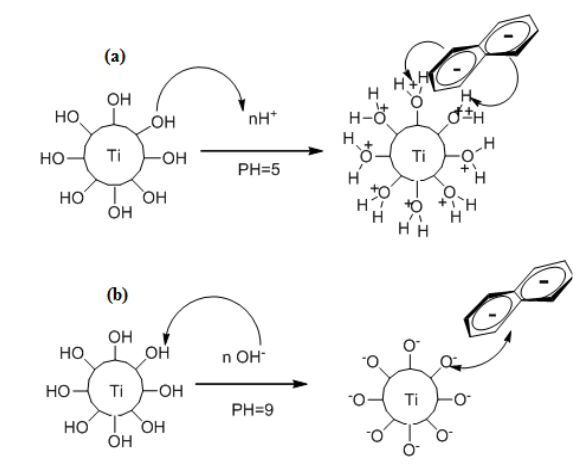
Figure 6. Point zero (pzc) of TiO pH, b) basic